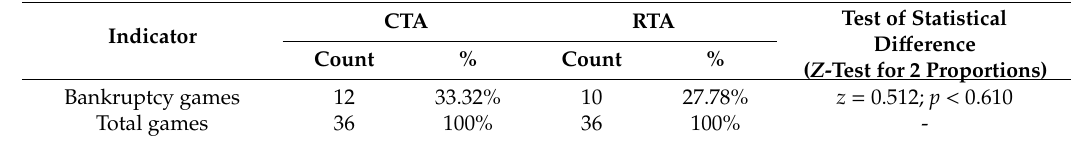
Table 3. Number of bankruptcy games.